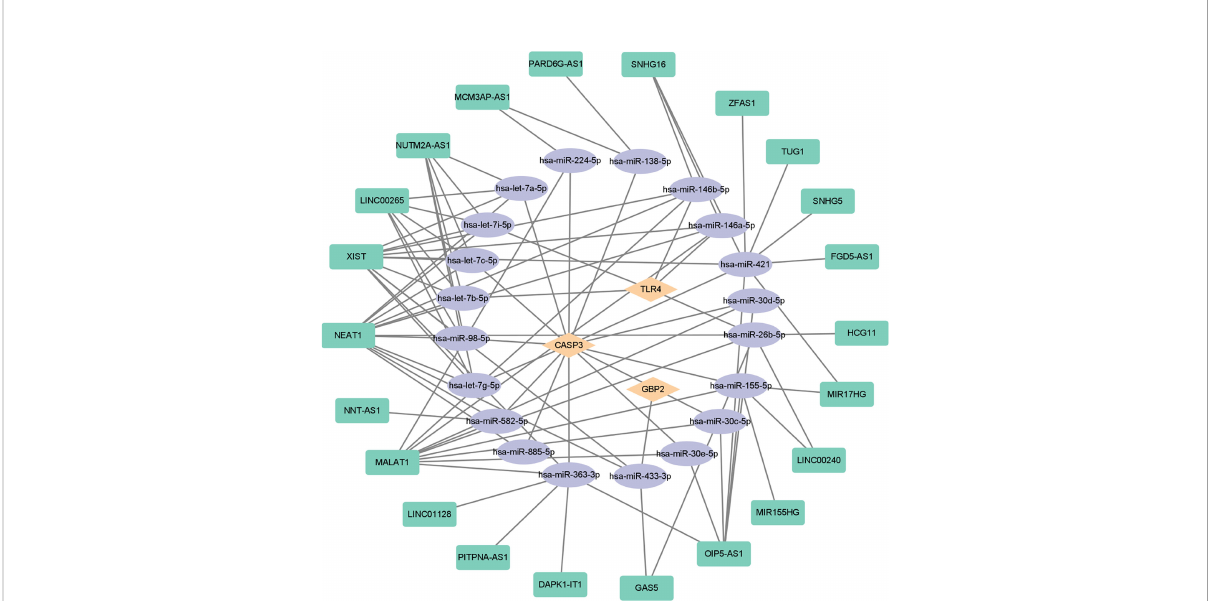
FIGURE 10 ceRNA-regulating networks. The yellow diamond represents the protein coding genes, the purple circle represents miRNAs, and the green rectangle represents lncRNAs. The black lines indicate the interaction of lncRNA – miRNA – mRNA. ceRNA, competing endogenous RNAs; miRNAs, microRNAs; lncRNAs, long non-coding